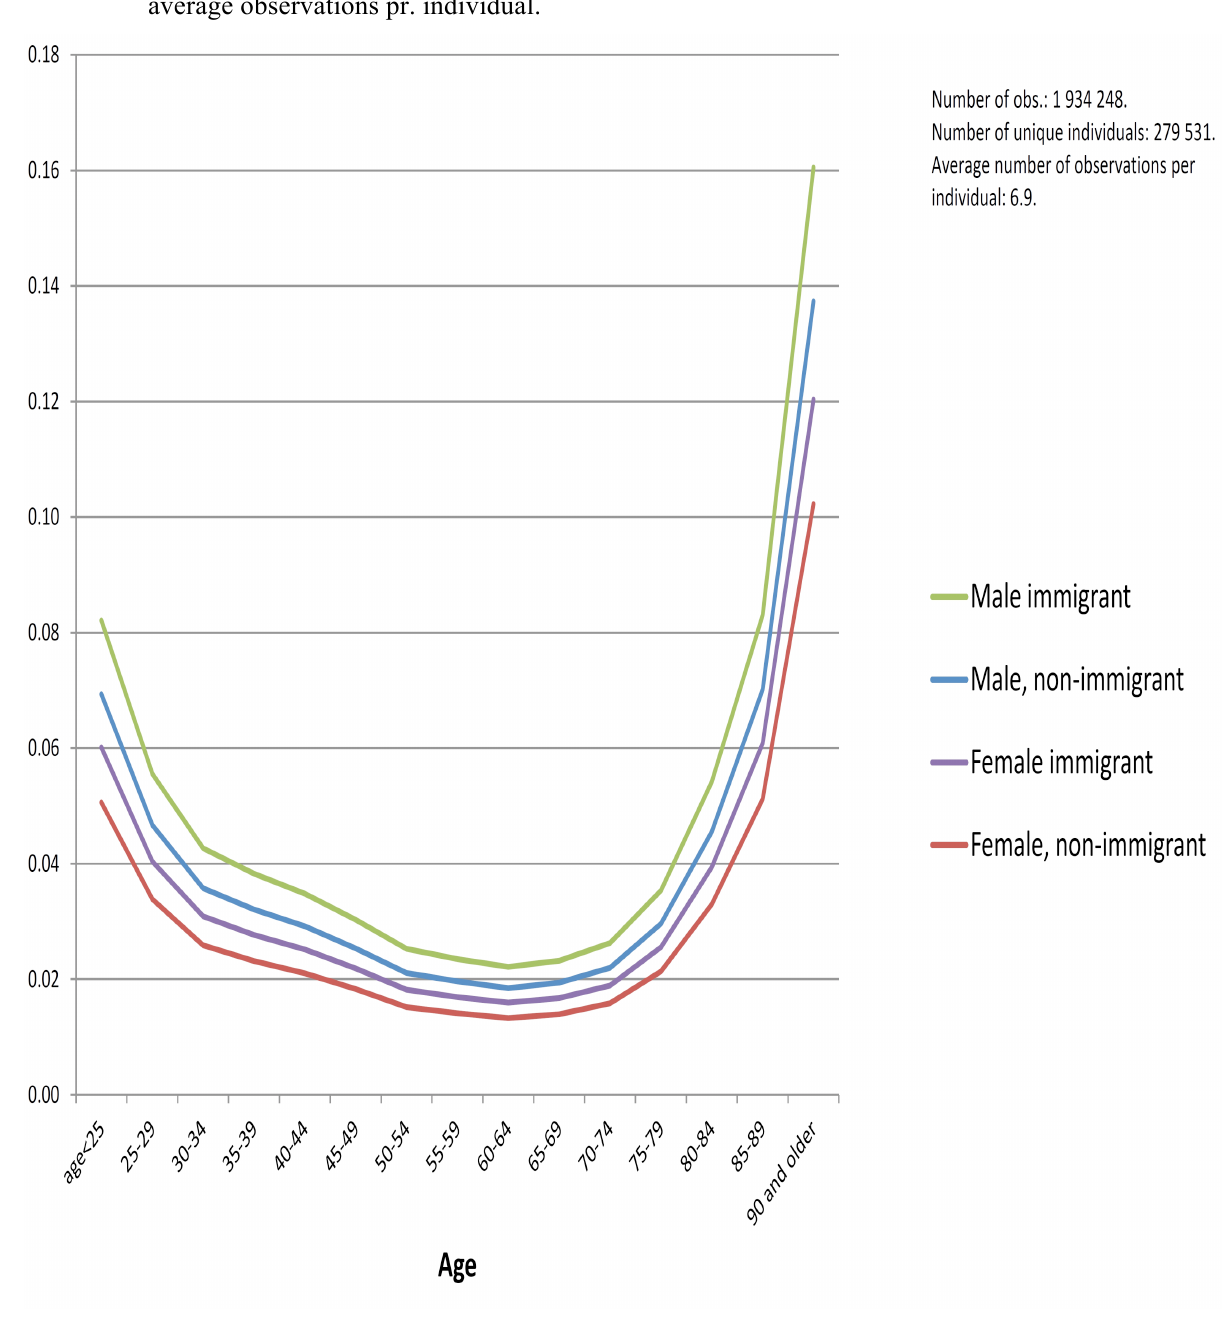
Figure 1: The impact of age on predicted probabilities for seeking care at the EW – Based on 1,934,248 observations by 279,531 unique individuals with 6.9 average observations pr.